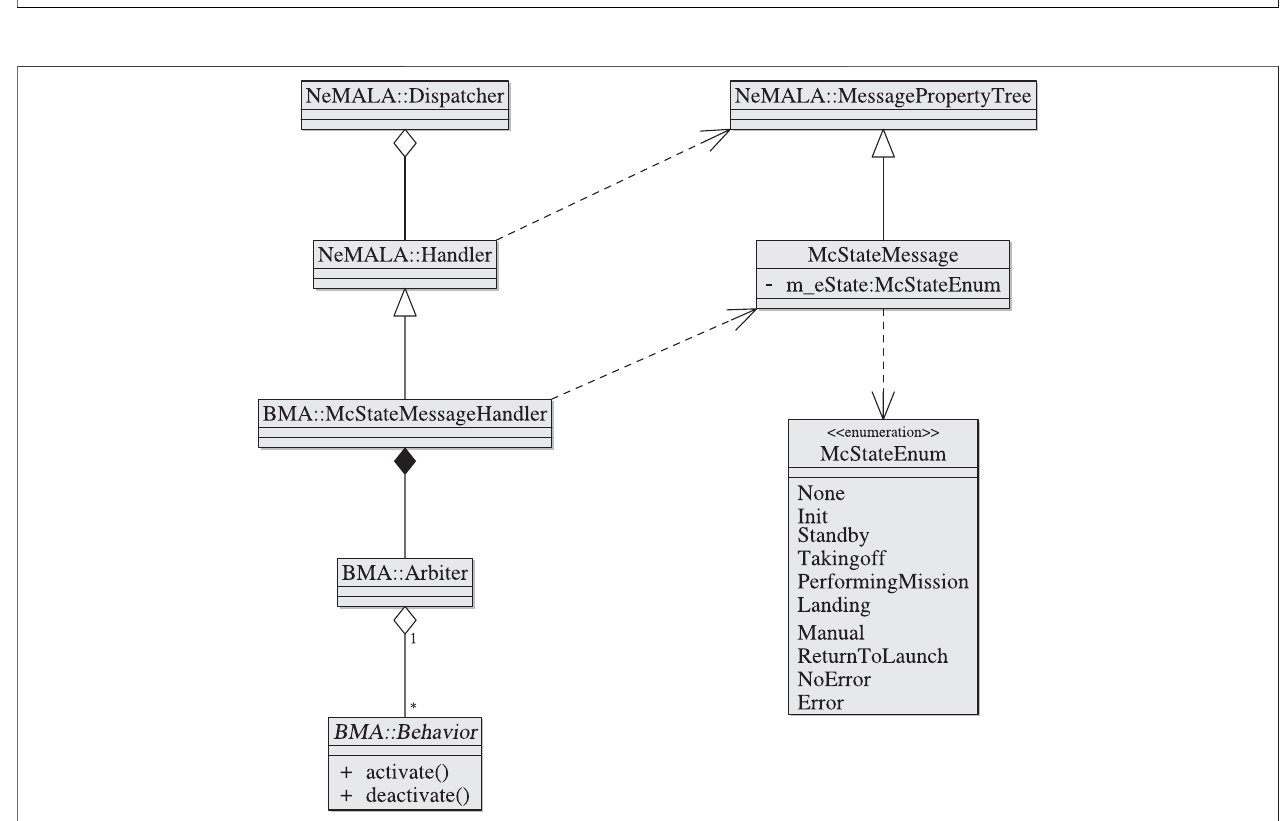
FIGURE 5 | AntAlate ’ s Behavior Module Arbiter class diagram. The behavior abstract class is a framework